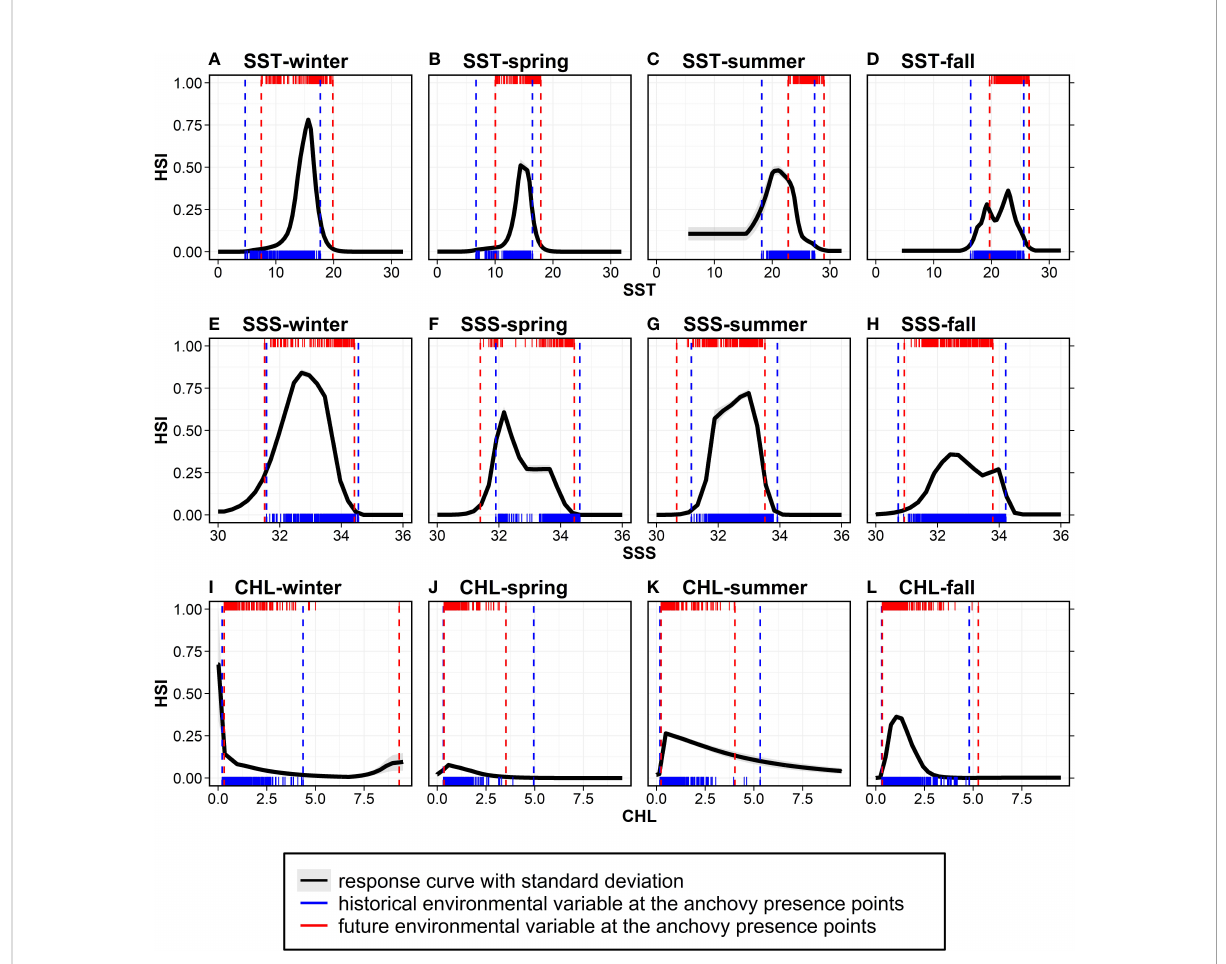
FIGURE 7 The species response curves of the environmental variables derived from the MaxEnt: (A – D) SST, (E – H) SSS, and (I – L) CHL from winter to fall. Black solid lines and grey shading indicate the averages and standard deviations of the ten replicated responses. Blue rug plots indicate the values of the environmental variables at the anchovy presence points, and blue vertical dashed lines show the ranges of the environmental variables (minima and maxima of the blue rug) during the study period (2000 – 2015). The red rug plots indicate the future environmental variables at the anchovy presence points (identical points to the historical period), and the red vertical dashed lines show the future environmental ranges under RCP 8.5. HSI, habitat suitability